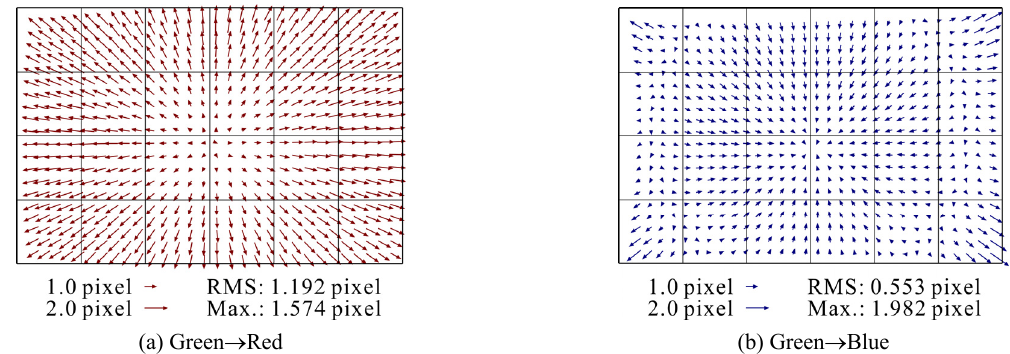
Figure 4. Displacement vectors caused by chromatic aberration in the image shown in Figure 2